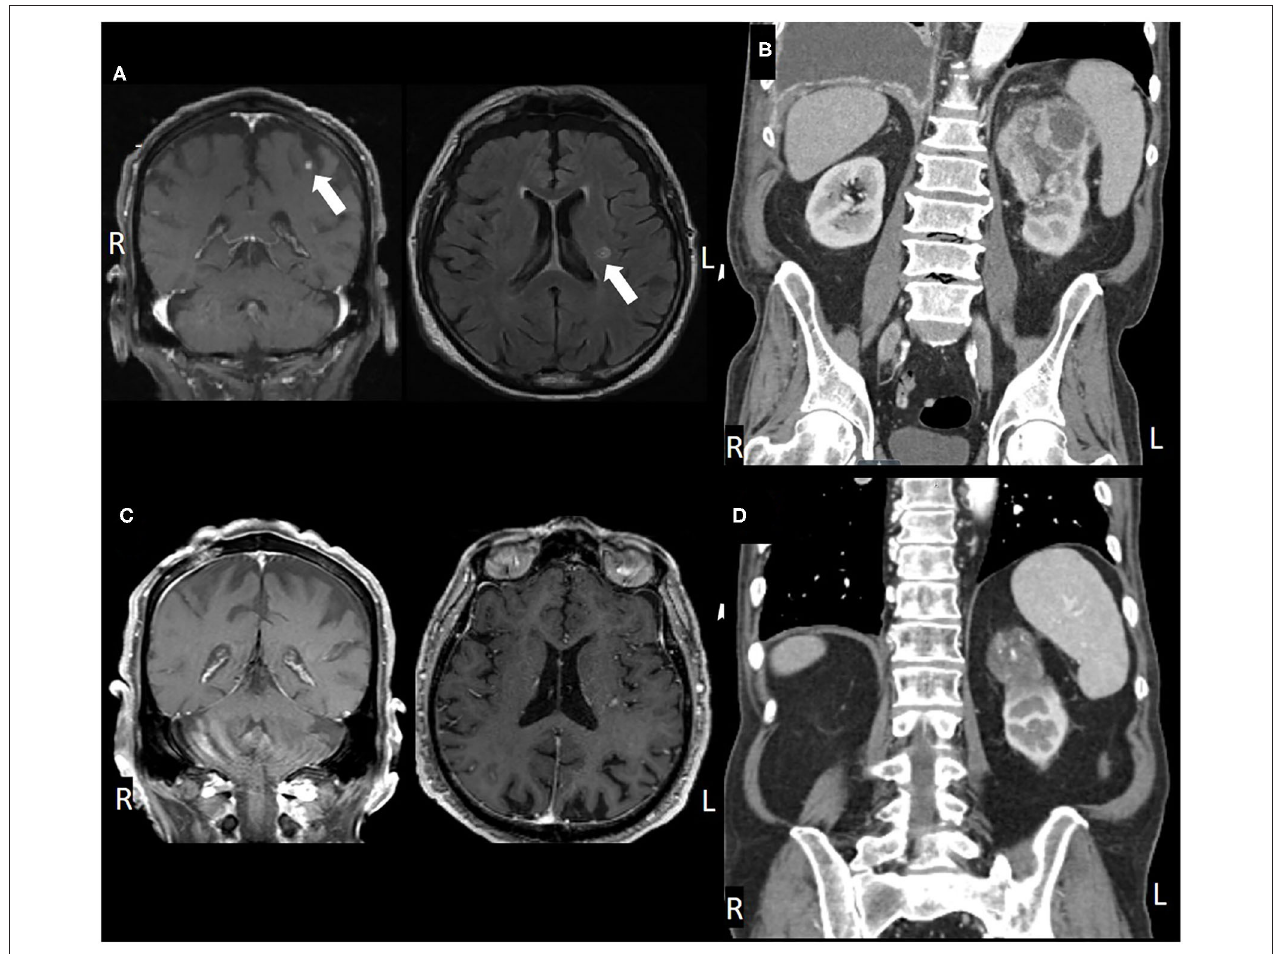
FIGURE 2 | (A) Pre-treatment MRI, coronal, and axial views, (B) post-SRS and immunotherapy MRI, (C) pre-treatment CT, coronal view, and (D) post-treatment